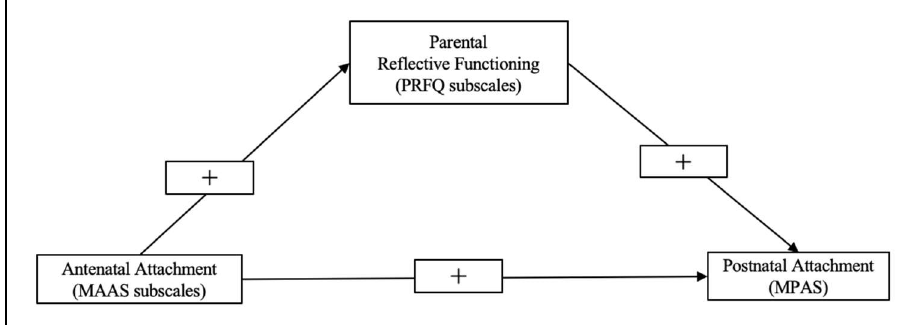
Figure 1. The conceptual model.